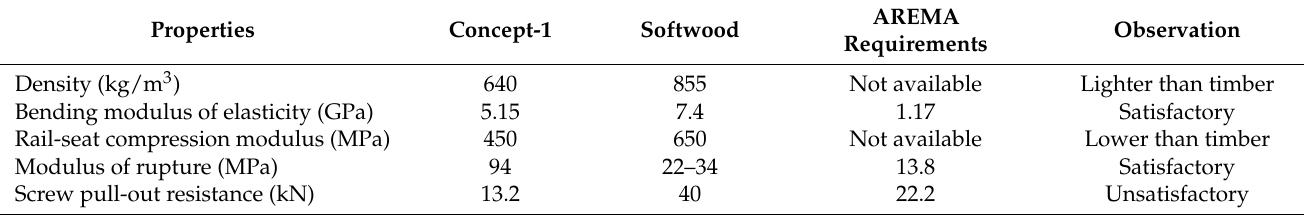
Table 4. Performance Comparison of PU Foam Core FRP Sleeper